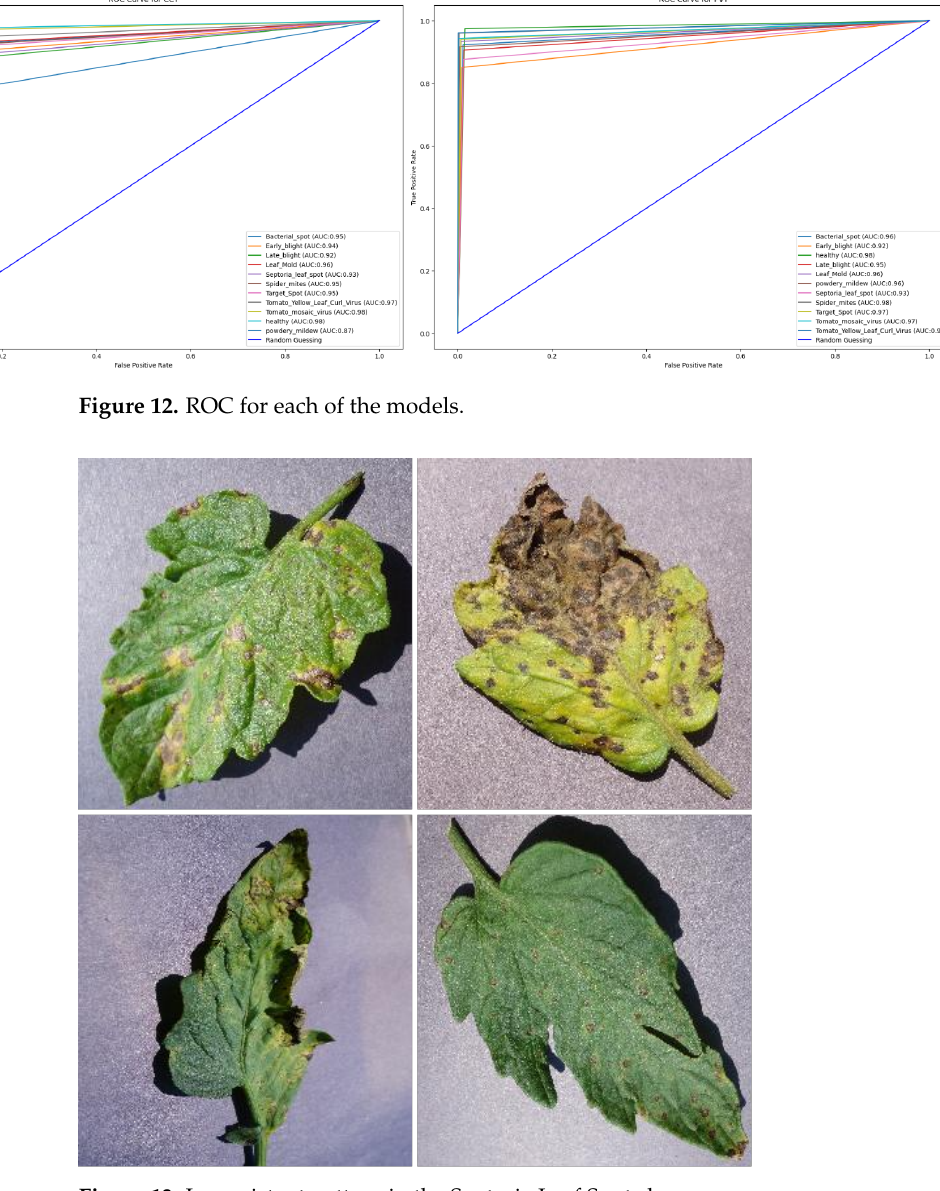
Figure 13. Inconsistent pattern in the Septoria Leaf Spot